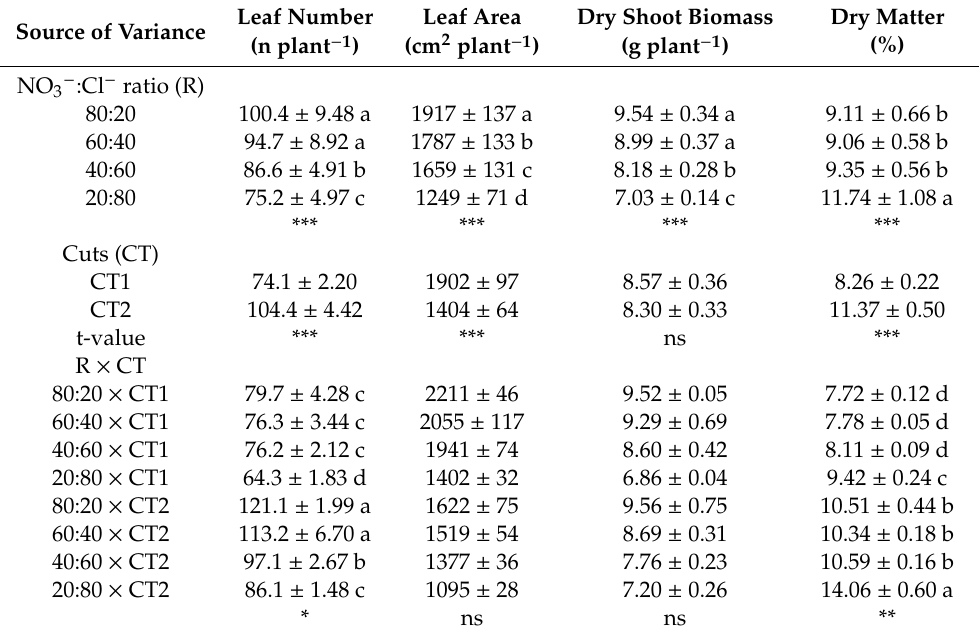
Table 1. Analysis of variance and mean comparisons for growth parameters and biomass production of greenhouse basil cultivated under four NO 3 − :Cl − ratios (R) in the nutrient solution and harvested in two successive cuts